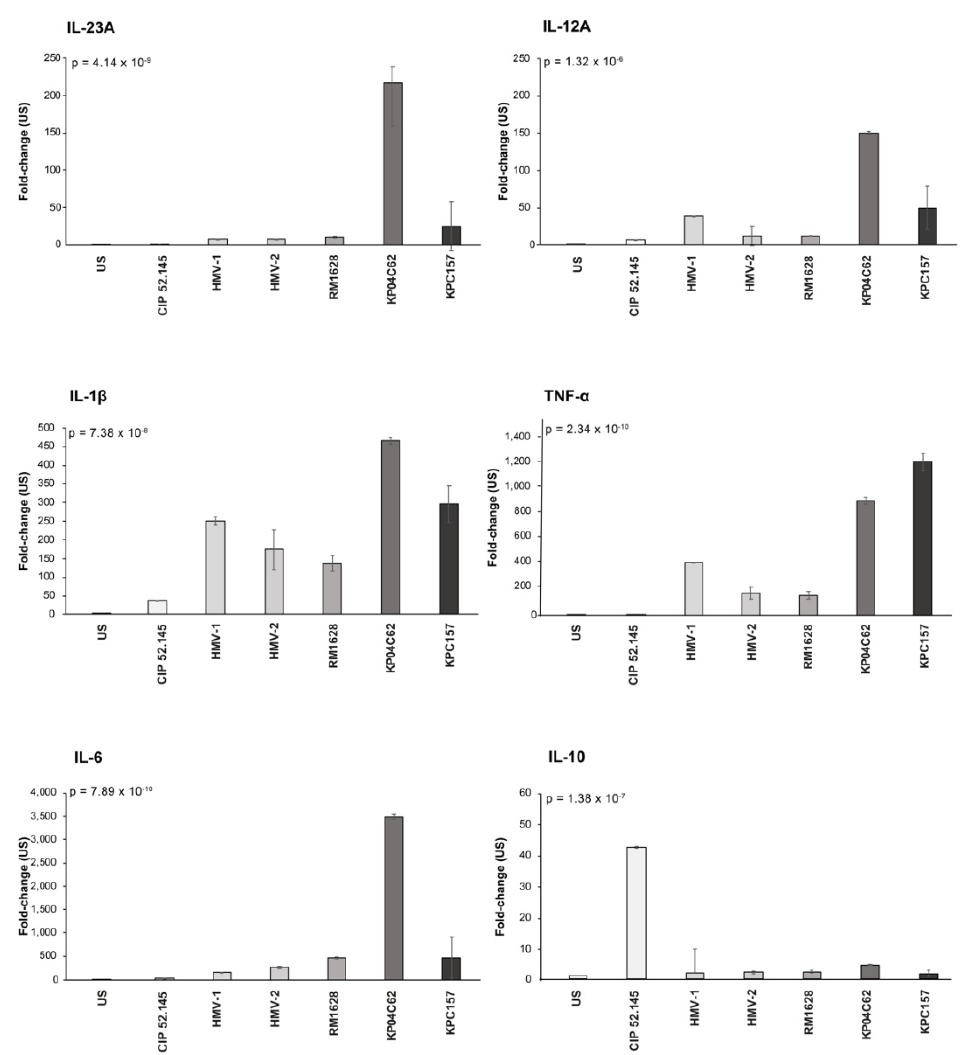
Figure 2. Cytokine expression by DCs cultured in presence of live K. pneumoniae strains; the global p -value obtained by ANOVA is reported.